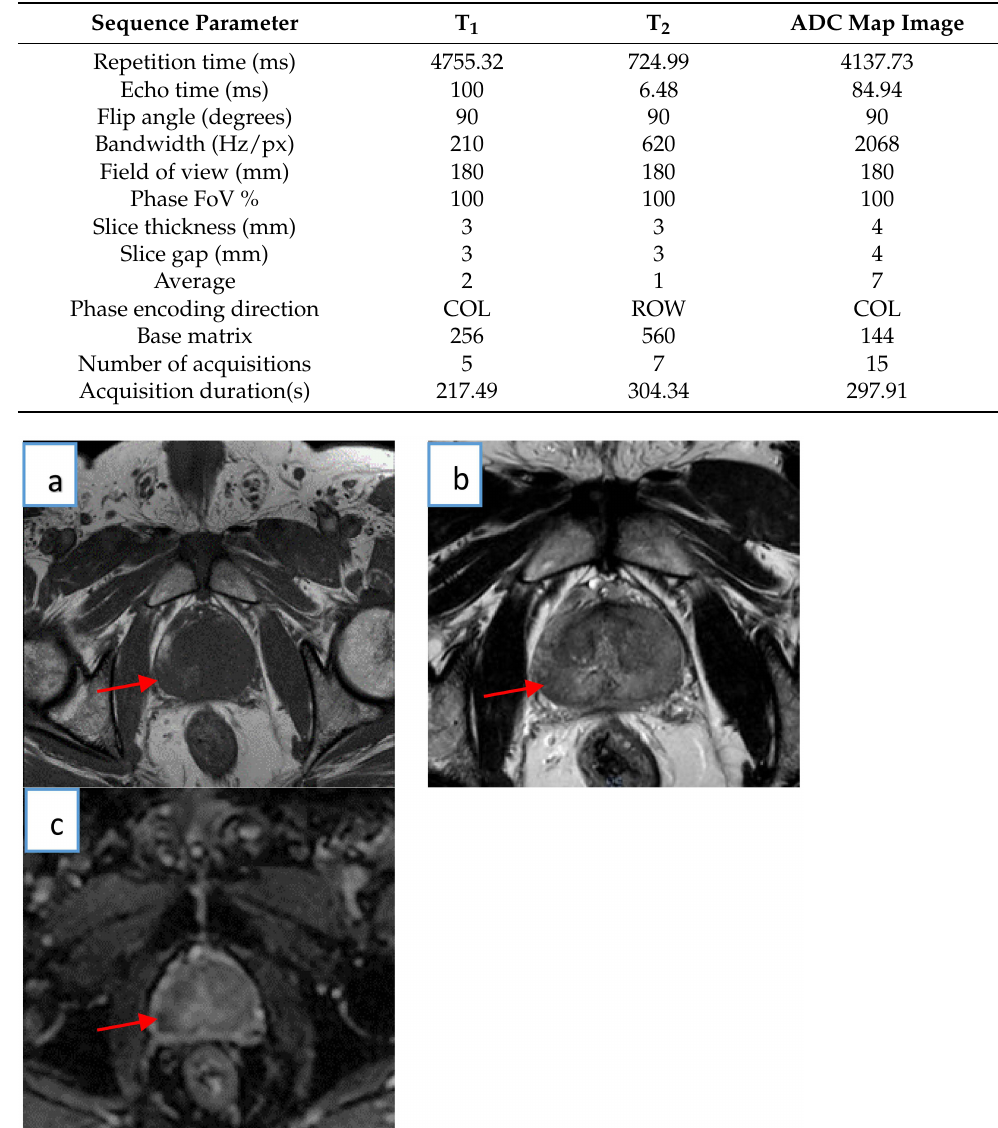
Figure 2. Significant tumor from a single axial slice (arrow images); ( a ) T 1 -weighted image; ( b ) T 2 -weighted image; ( c ) ADC map image. Images are from a 58-year-old patient with a significant tumor ( ≥ 3 + 4) according to the Gleason and ISUO